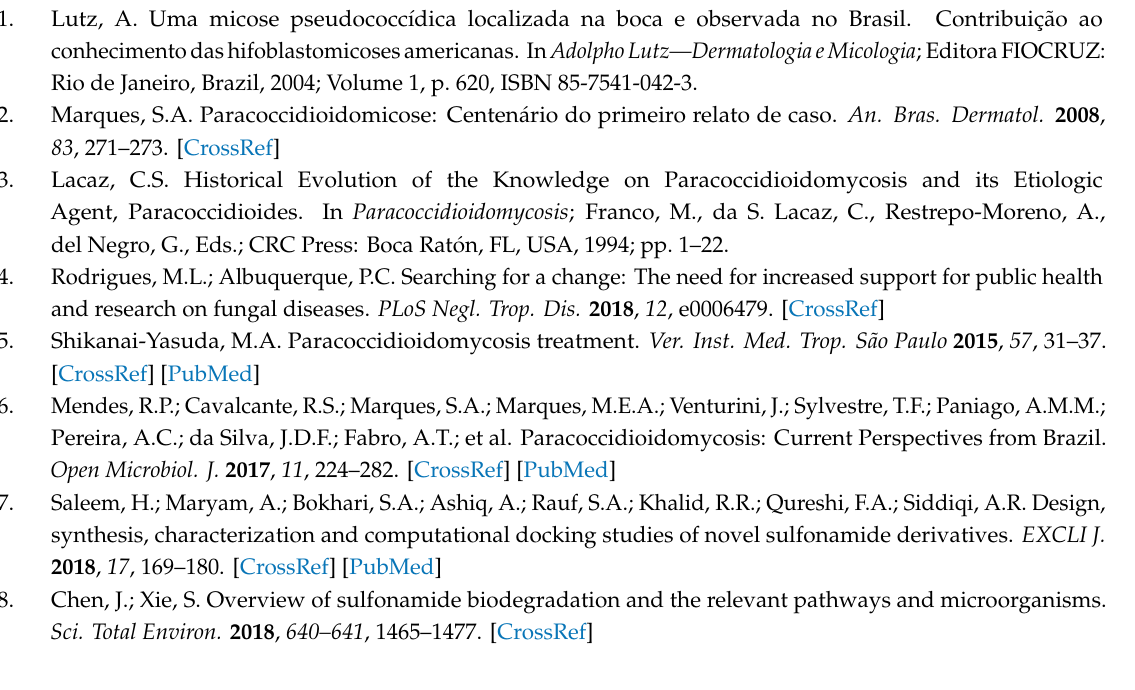
Table S1: Antifungal derived from synthetic and semi-synthetic compounds tested against Paracoccidioides spp., Table S2: Table S4: Patents required to Paracoccidioidomycosis